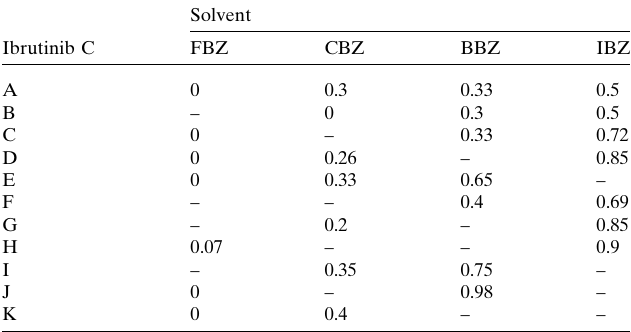
Table 1 Solvent content in slurry experiments (A: 4 solvents, B–E: 3 solvents, F– K: 2 solvents) as estimated by l H